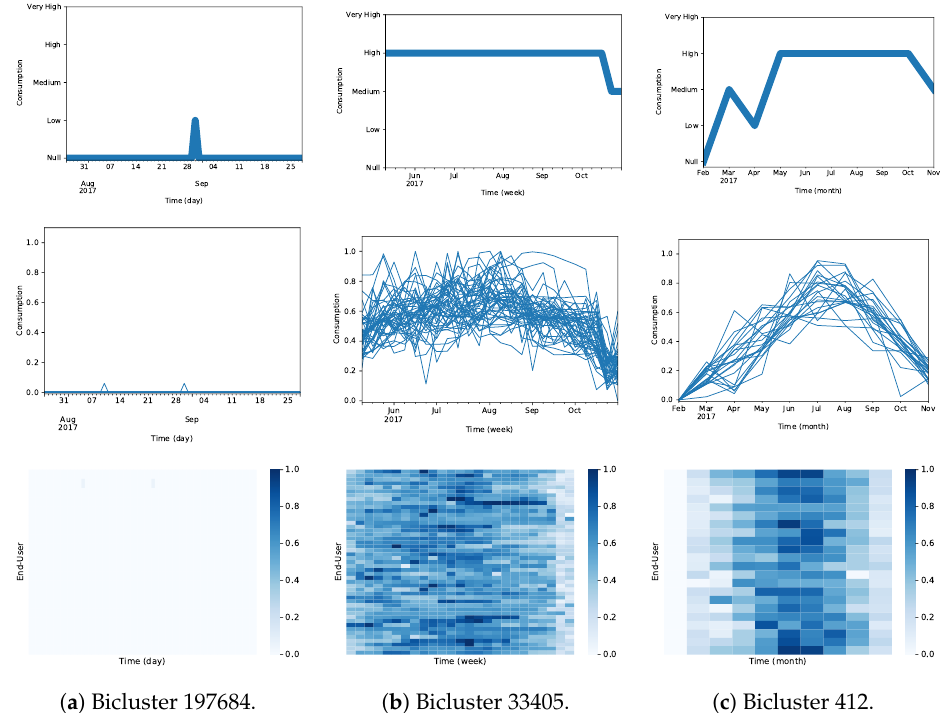
Figure 23. Illustration of the selected constant biclusters allowing noise (Bicluster 197684, Bicluster 33405, and Bicluster 412) found on the daily, weekly and monthly dataset. This figure shows the consumption patterns on the first row, the user consumption scaled time series on the second row, and the scaled data heatmap on the third row. Table 6. Properties of the biclustering solutions found assuming shifted factors at InfraQuinta,